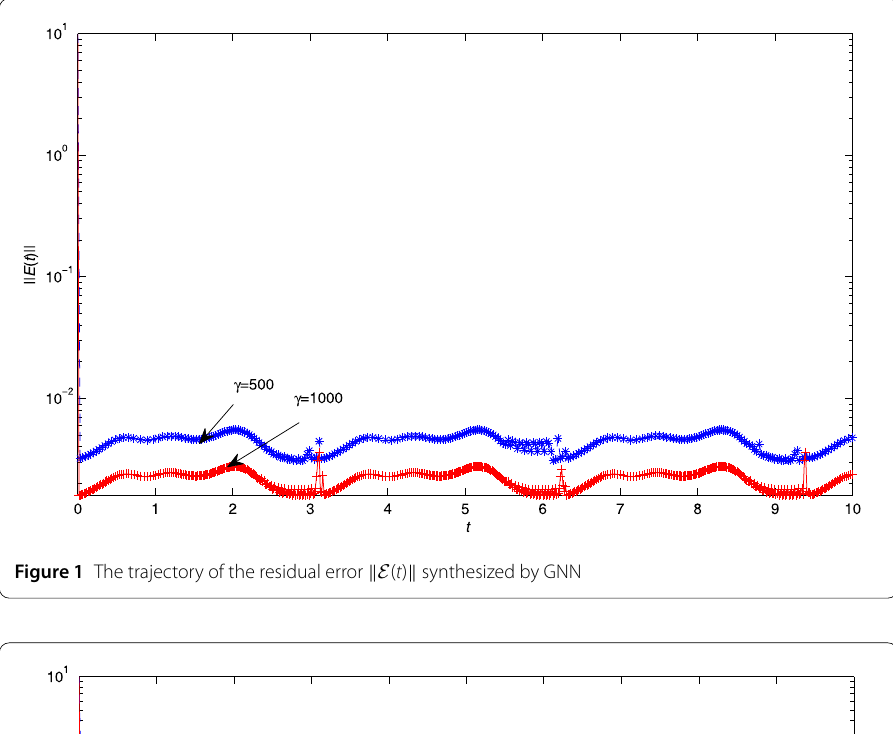
Figure 1 The trajectory of the residual error (cid:9) E ( t ) (cid:9) synthesized by GNN